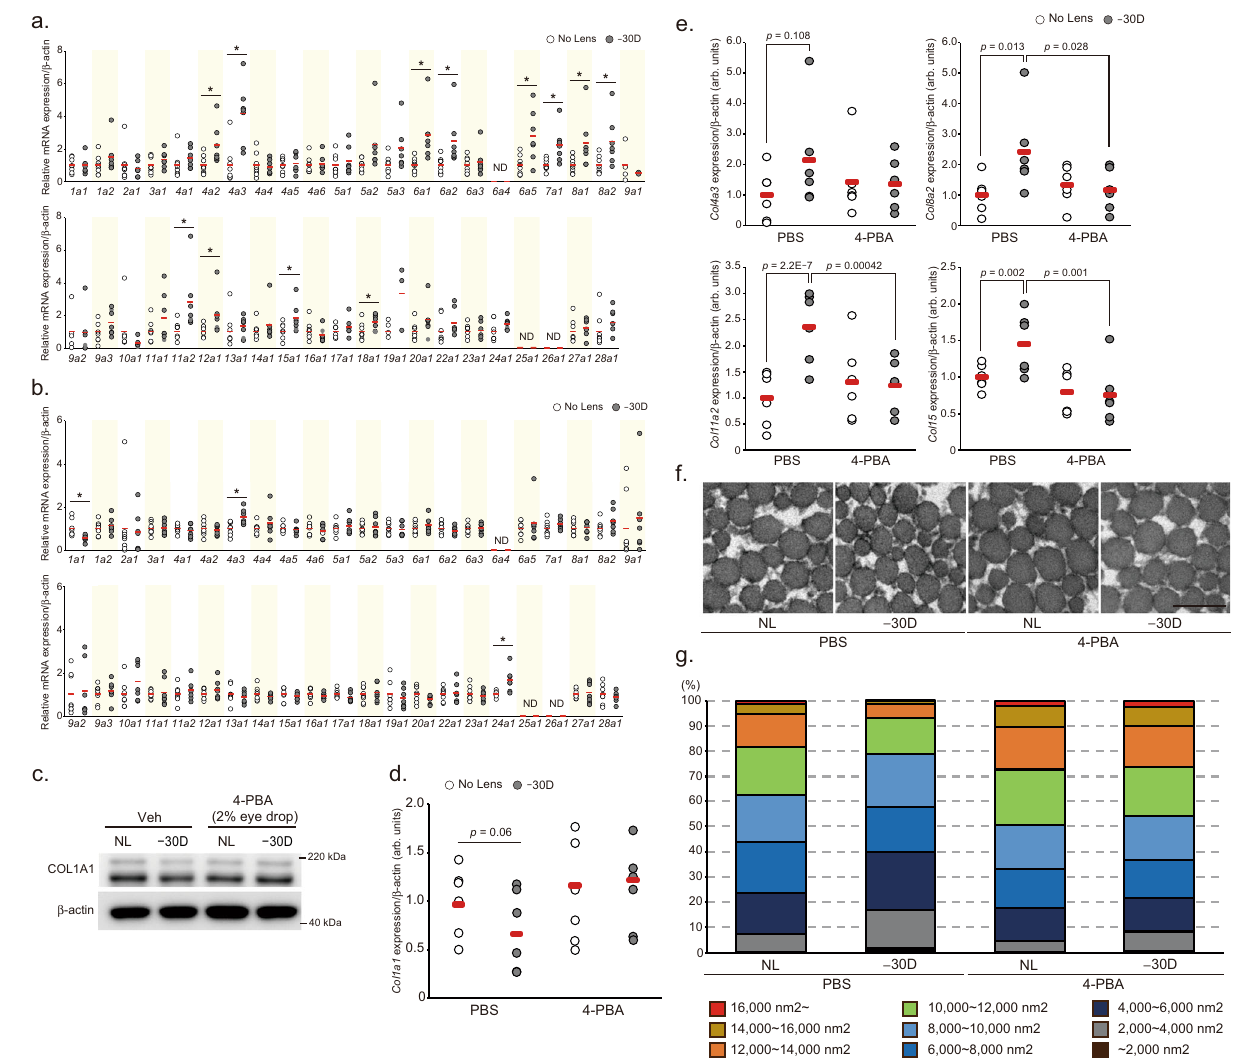
− 30D: minus 30 D lens-wearing eye. d The effect of LIM and 4-PBA instillation on Col1a1 mRNA expression in sclerae ( n =6, respectively). The p values were deter- mined by Generalized Estimating Equations. e 4-PBA instillation cancels LIM- induced increase in Col4a3, Col8a2, Col11a2, and Col15a1 mRNA expression eval- uated by qPCR in sclerae ( n =6 per group); The p values were determined by two- tailed Generalized Estimating Equations. f Transmission electron microscopy ima- ges of sclerae collagen fi ber in No lens control (NL) and − 30 D lens worn ( − 30D) sclera of PBS or 4-PBA instilled C57BL6J mouse. Representative images of three biologically independent samples; scale bar, 200nm. g 100% stacked bar charts of scleral collagen fi ber area ( n =3 biologically independent samples). Five